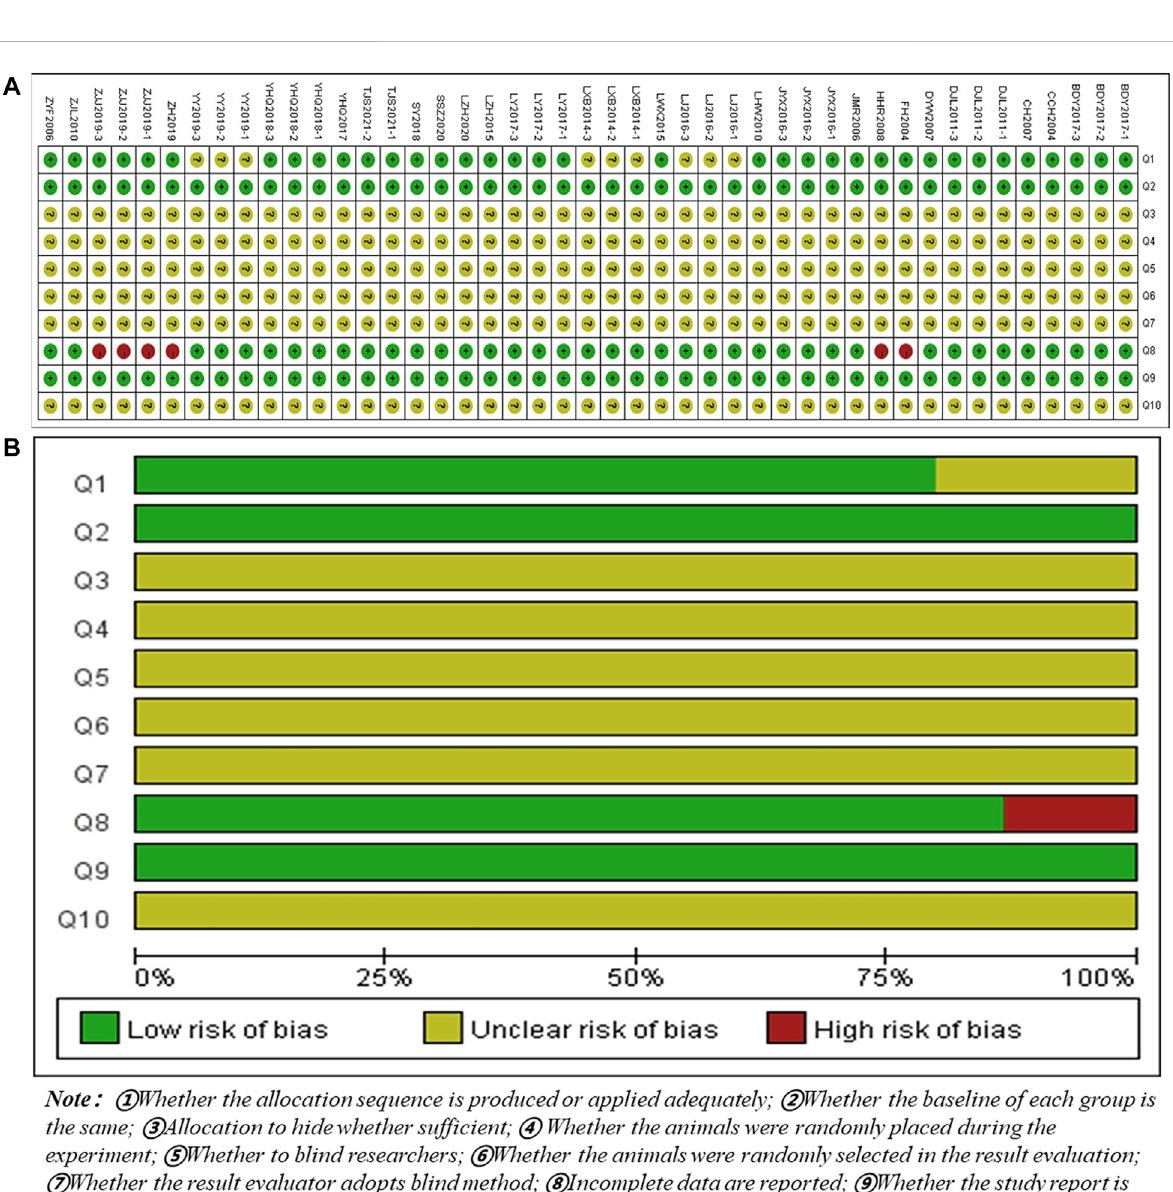
FIGURE 3 (A) Risk of bias summary. (B) Risk of bias